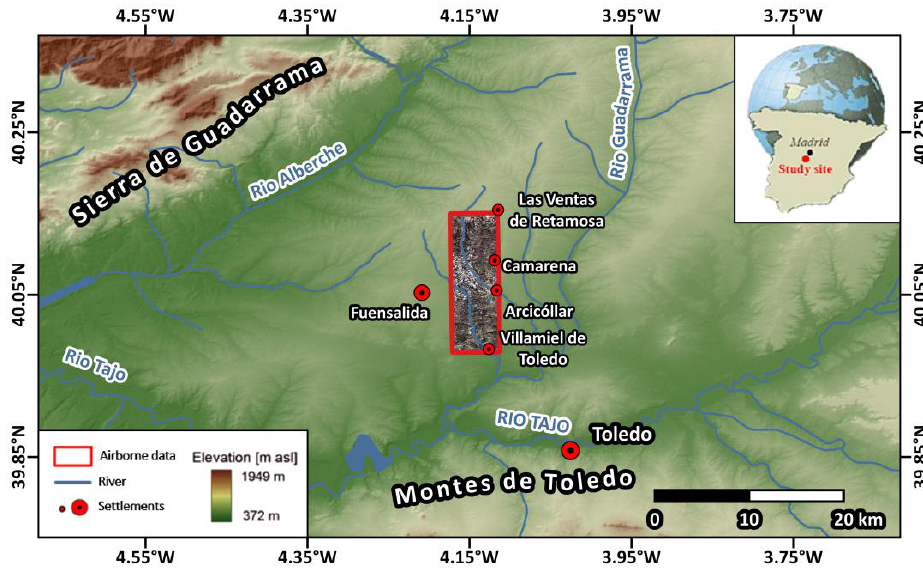
Figure 2. Study site region with airborne data coverage.